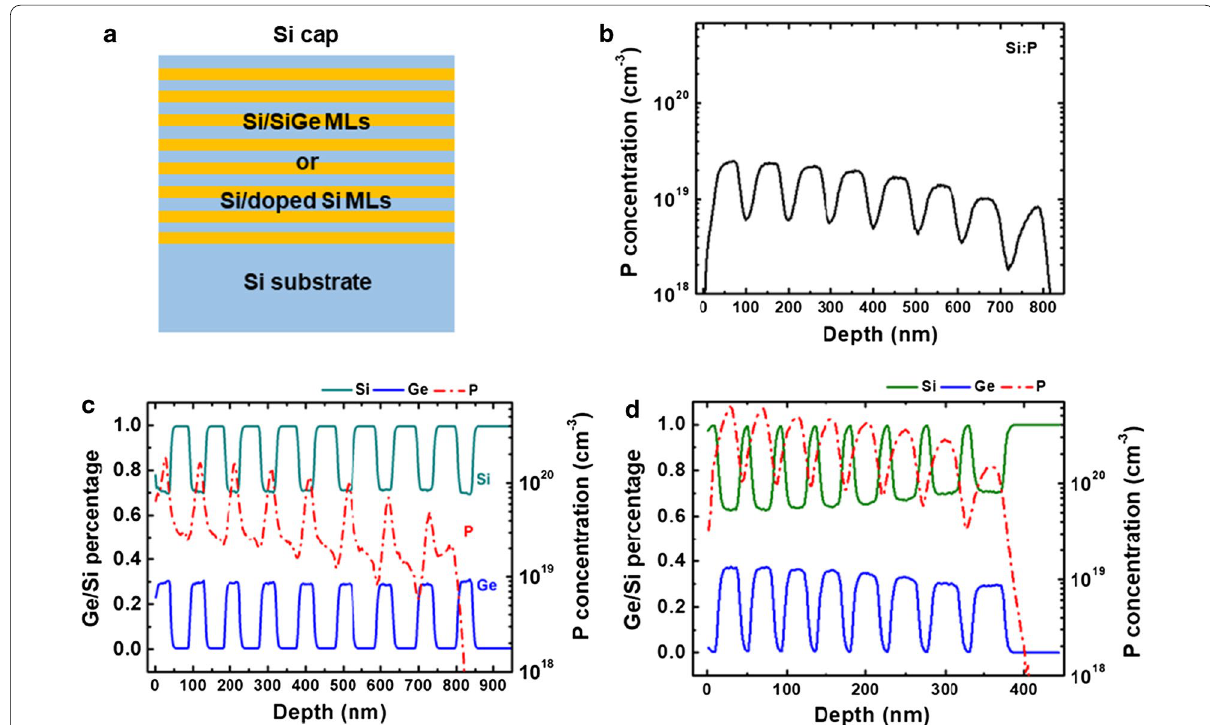
Fig. 1 a Schematic diagram of P-doped Si/SiGe/Si MLs. b P-doping concentration of undoped Si/P-doped Si MLs. Ge/Si percentage and P concentration of c undoped Si 0.72 Ge 0.28 /P-doped Si, d undoped Si/P-doped Si 0.72 Ge 0.28 MLs. No purging and undoped spacer layer were